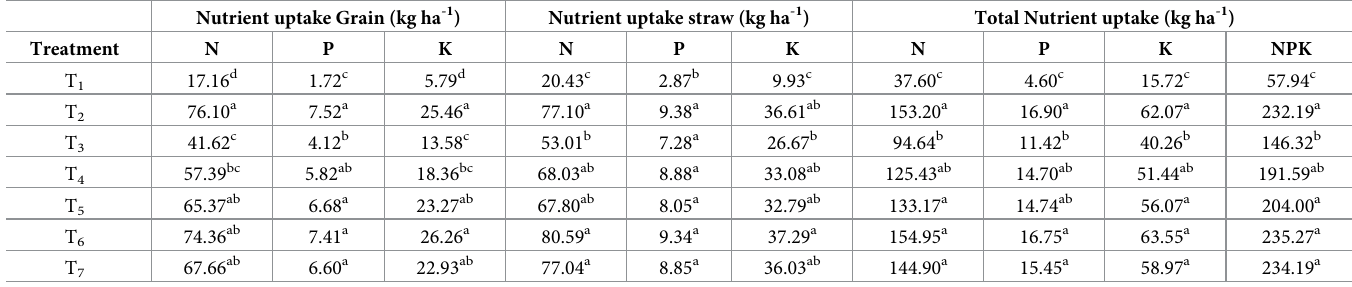
Table 5. Effect of different weed management practices on nutrient (NPK) uptake in soybean. Nutrient uptake Grain (kg ha -1 ) Nutrient uptake straw (kg ha -1 )